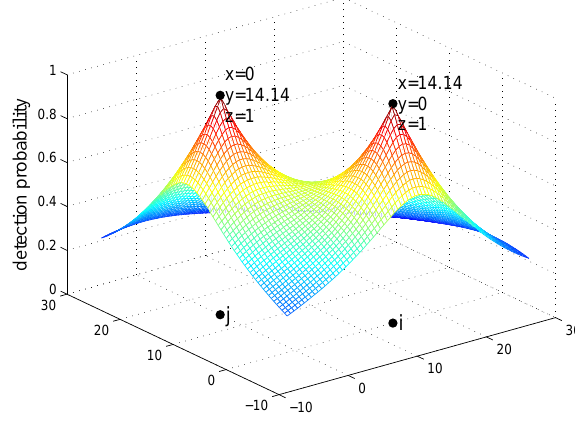
Figure 2. Change in collaborative detection probability with two sensors i and j .